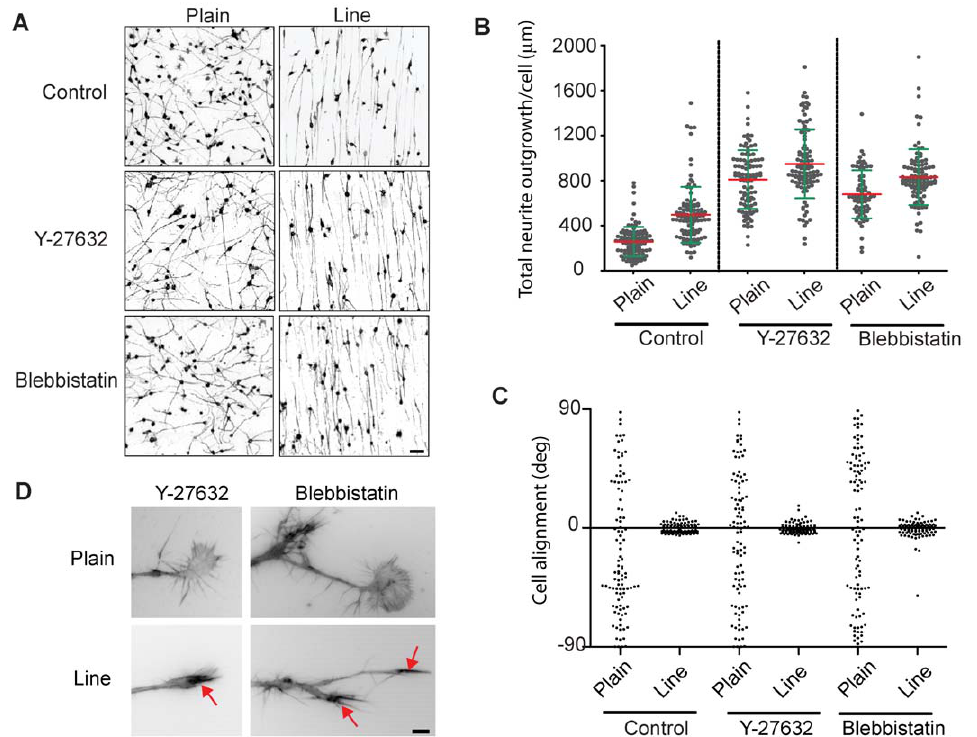
Figure 5. Effect of contractility inhibitors on neurite outgrowth on plain and line substrates. ( A ) Representative images of tubulin-stained N1E-115 cells incubated with 10 m m Y-27632 or 10 m m blebbistatin for 24 h on plain and line substrates. ( B ) Cumulative graph of neurite lengths on a cell basis of the two different treatment and substrate. Mean (red) and standard deviations (green) are shown. Data is based on control of 104 cells for plain and 105 cells for line, Y-27632 treatment of 101 cells for plain, 101 cells for line, blebbistatin of 67 cells for plain and 100 cells for line. P values (T- test) between plain and line substrates ,, 0.0001. ( C ) Quantification of neurite orientation at 24 hours. Angle measurements of neurite orientation compared to an arbitrary (plain substrate) or to the line direction (line substrate) are shown. ( D ) Growth cone morphologies on plain and line substrates in presence of Y-27632 and blebbistatin drugs. High resolution F-actin pictures are shown. Bars: (A) 100 m m; (D) 5 m m.